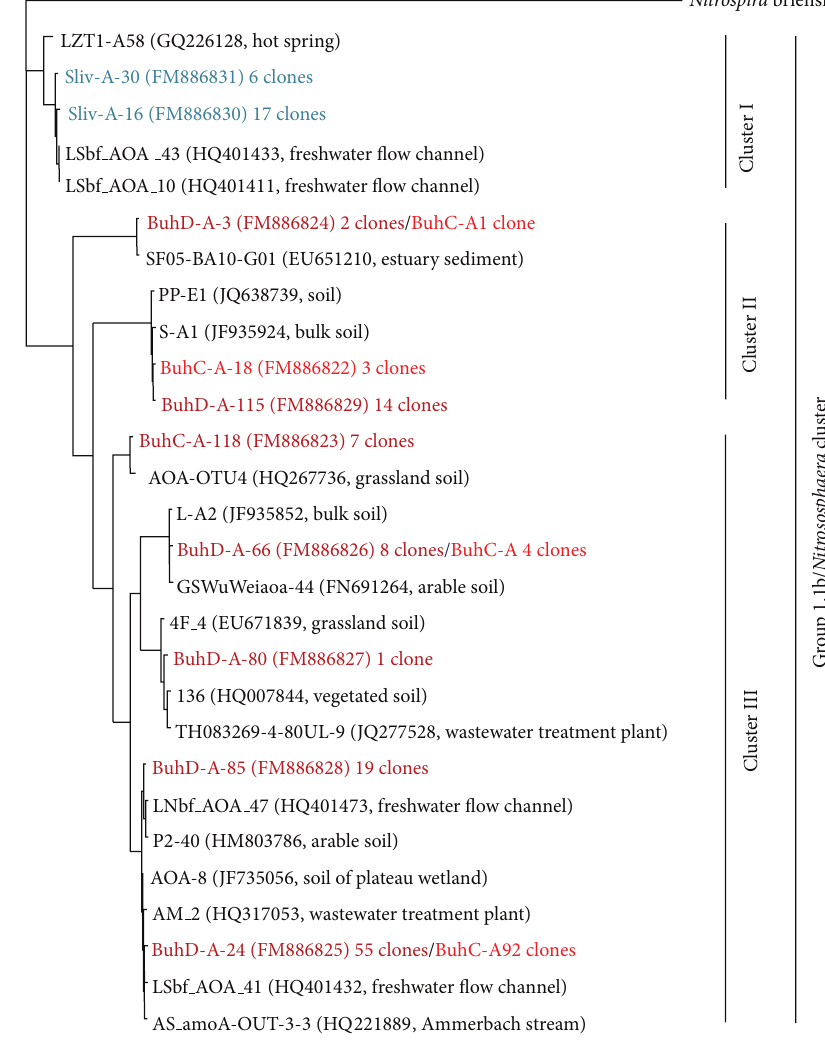
Figure 4: Phylogenetic analysis of archaeal amo A gene sequences retrieved from uranium mining sites BuhC, BuhD, and Sliv. The tree was constructed using the neighbour-joining method. The amo A sequence of Nitrospira briensis was used as an outgroup. The scale bar represents 0.1 changes per nucleotide